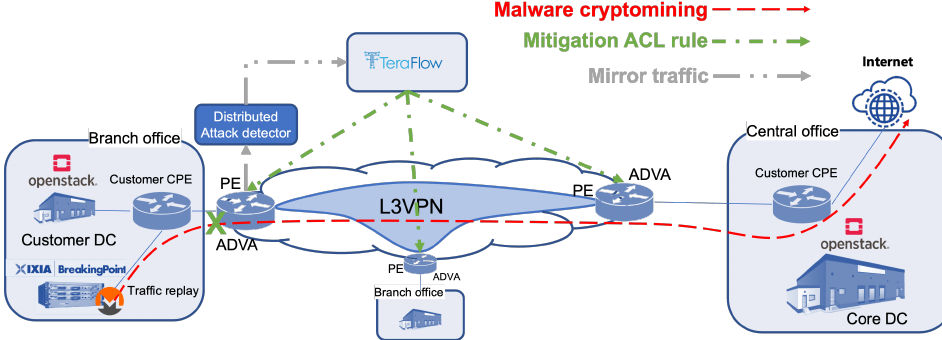
Figure 1. Global overview of the cyber threat analysis and protection process